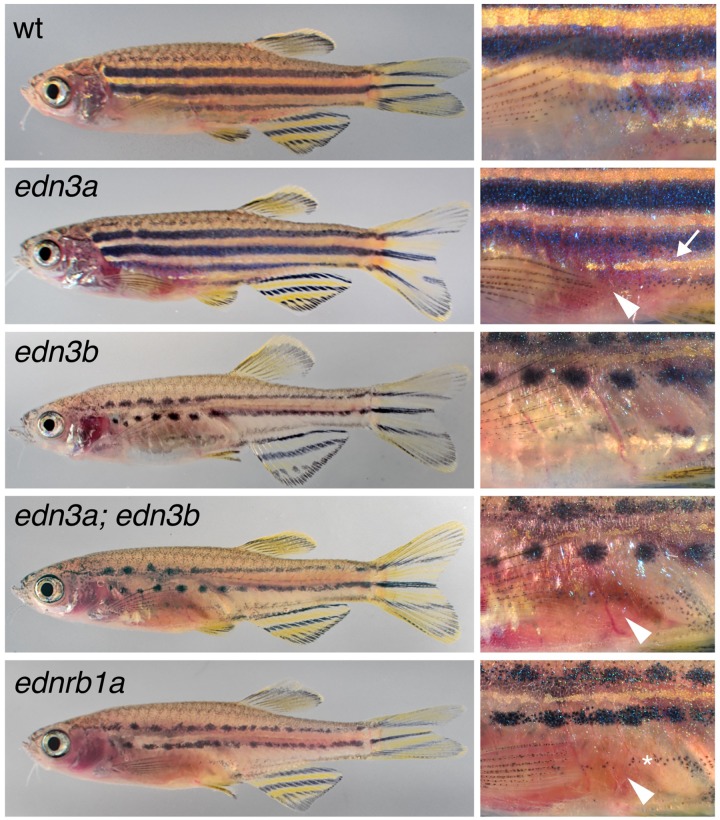
Edn3 and Ednrb1a mutants of D. rerio.Shown are wild-type (wt) and homozygous mutants for edn3a and edn3b, double mutant edn3a; edn3b, and ednrb1a. edn3a mutants had normal hypodermal pigment pattern, including iridophore interstripes (arrow, right) but lacked peritoneal iridophores (arrowhead). edn3b mutants had hypodermal iridophore and melanophore deficiencies but normal peritoneal iridophores. Fish doubly mutant for these loci exhibited both defects and resembled ednrb1a mutants. At the very young adult stages shown, ventral-most melanophores of ednrb1a mutants (*) have yet to coalesce into spots.